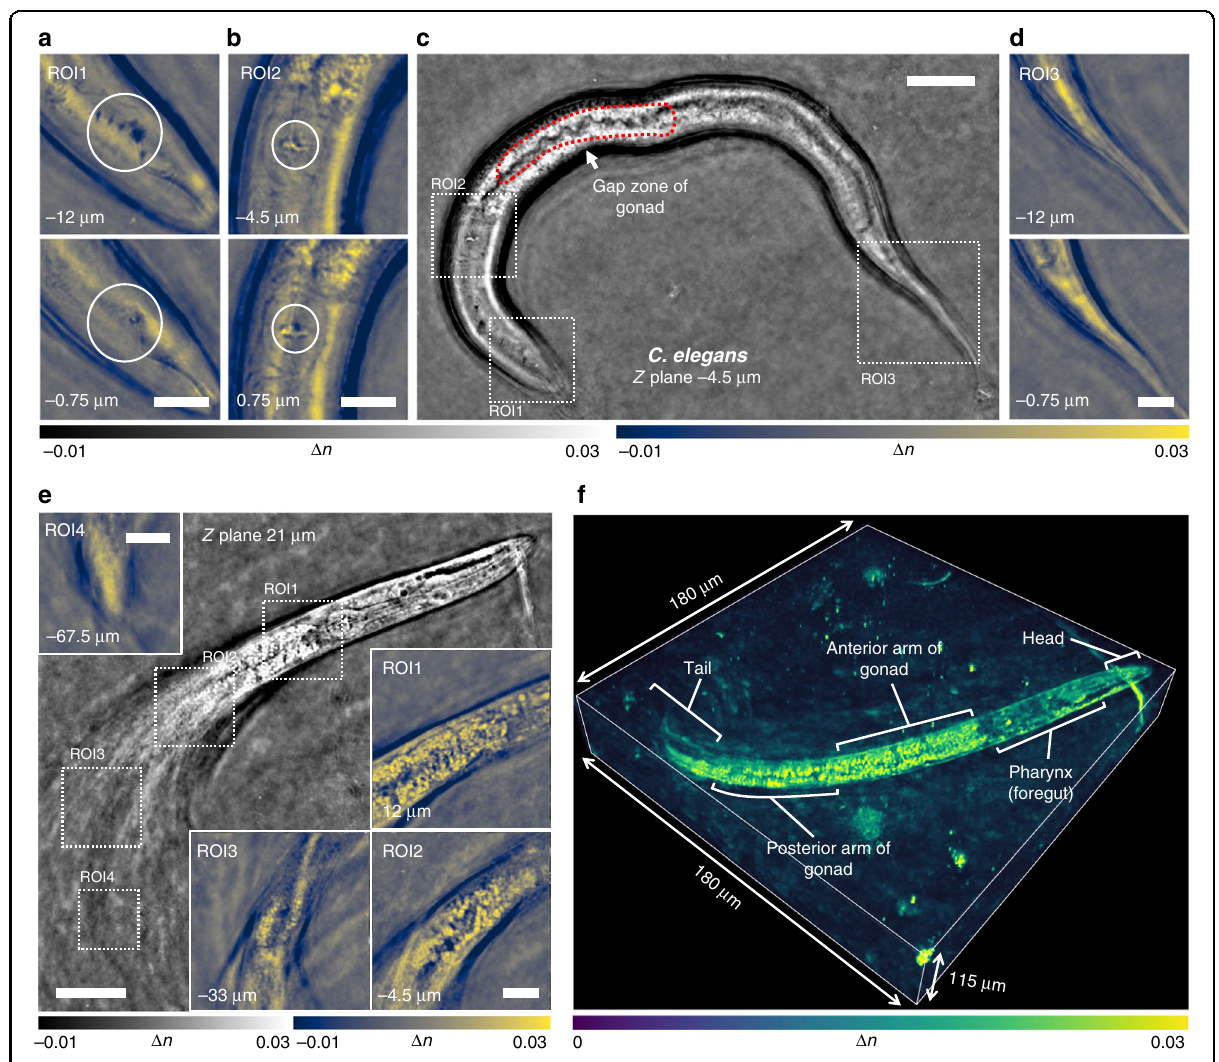
Fig. 4 Tomographic RI reconstruction of fi xed C. elegans at different stages of the life cycles. a – e Full FOV and different tomogram ROIs at different positions and axial planes to illustrate the recovered RI slice results of C. elegans . f 3D RI rendering of C. elegans worm over a volume of 180 µm × 180 µm × 115 µm. Scale bars: 25 µm (Full FOV) and 10 µm